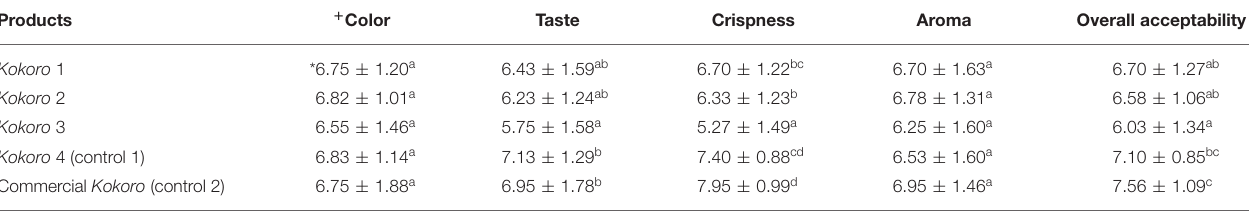
TABLE 7 | Sensory attributes of Kokoro from provitamin A maize genotypes and commercially purchased Kokoro . Products + Color Taste Crispness Aroma Overall